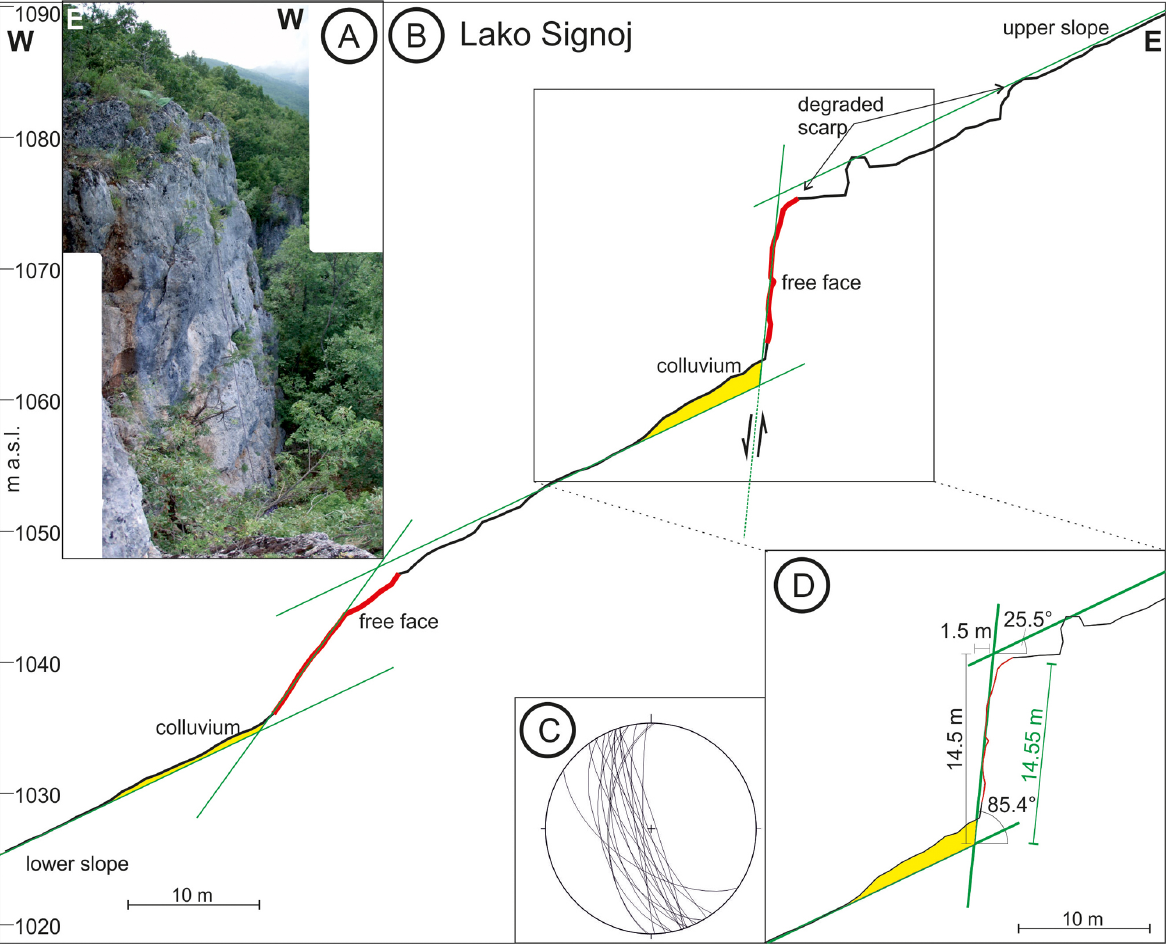
Figure 4. (A): Photograph of the Lako Signoj scarp. Yellow line gives the approximate position of the profile. (B): Complete profile and geo- metric reconstruction of the Lako Signoj fault (40°5811111N, 20°4810711E; 1076 m a.s.l. for location see Figure 1). Only the upper scarp was analysed in detail. No vertical exaggeration. Green lines show constructed angles of upper and lower slope and the fault plane. Red lines in- dicate the free face measured in the field. The colluvium (marked in yellow) is constructed from field data. (C): Stereonet plot of measure- ments from the fault plane. (D): Dip angles and offset derived from geometric